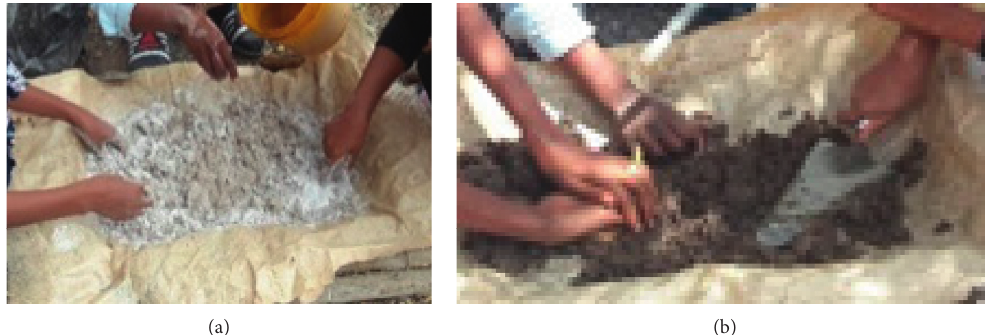
Figure 3: (a) Clay preparation process; (b) mixing of clay